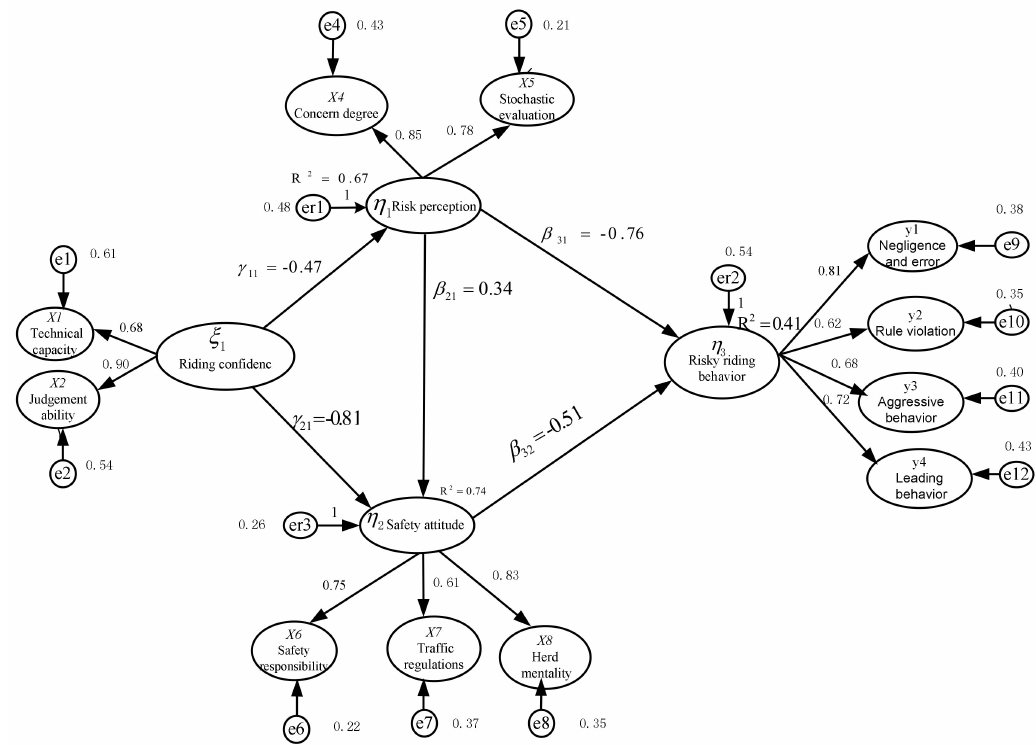
Figure 3. Fit results of the revised